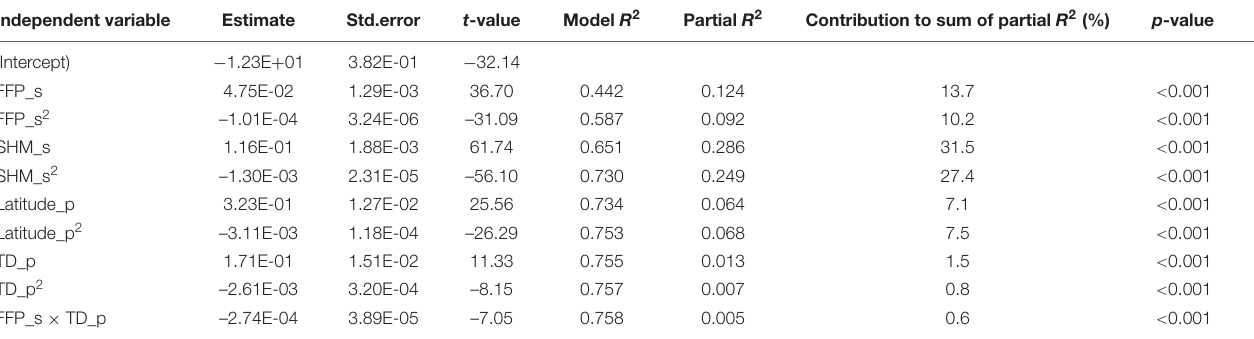
TABLE 4 | Summary statistics of the TraitSDM predicting tree height of Norway spruce populations at age 11 based on climate of site, as well as climate and geography of and provenance origin. Independent variable Estimate